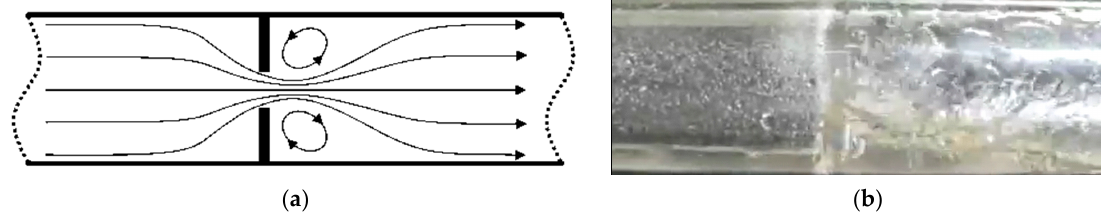
Figure 5. The accumulation of condensed liquid in front of the orifice. [22]. Figure 5. ( a ) local velocities in the fluid flow; ( b ) liquid condense on the orifice surface